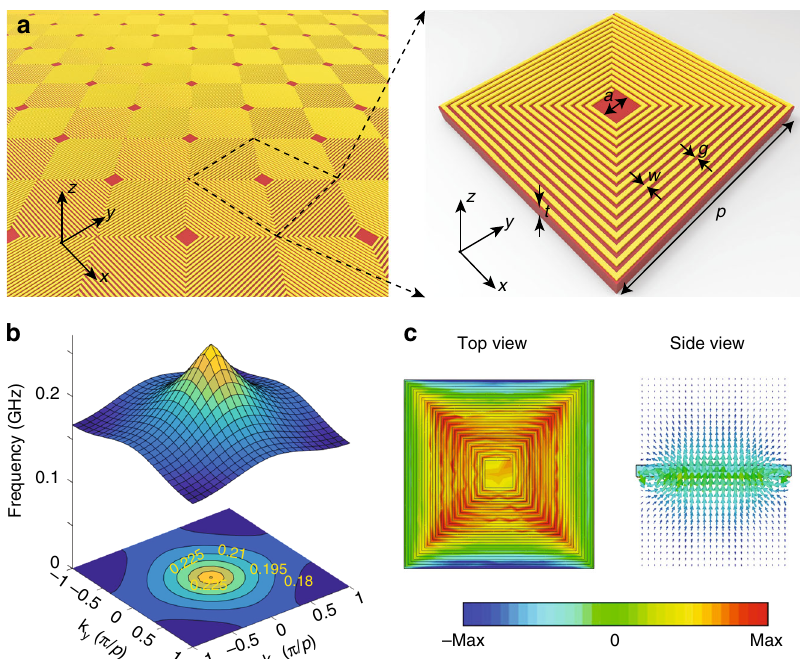
Fig. 1 Type-I hyperbolic metasurface. a Type-I hyperbolic metasurface consisting of coiling copper wires patterned on a dielectric substrate. The inset shows the unit cell details. Here, a = 2 mm; w = g = 0.2 mm; numbers of turns N = 15; p = 13.8 mm; and t = 1 mm. The thickness of the metal layer is 0.035 mm; the conductivity of copper is 5.7 × 10 7 S m − 1 ; the relative permittivity of the substrate is 2.55 + 0.001 i at 10 GHz. b Isofrequency contour of the dispersion in the fi rst Brillouin zone. c Side and top view of the magnetic fi eld distribution of the designer polariton, respectively. The color bar measures the magnetic fi eld